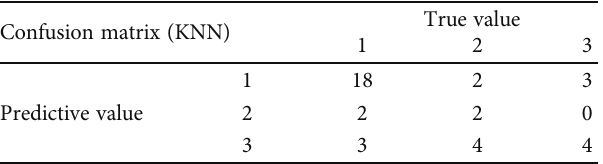
Table 6: Confusion matrix of optimized K -nearest neighbor algorithm for predicting ROP level.